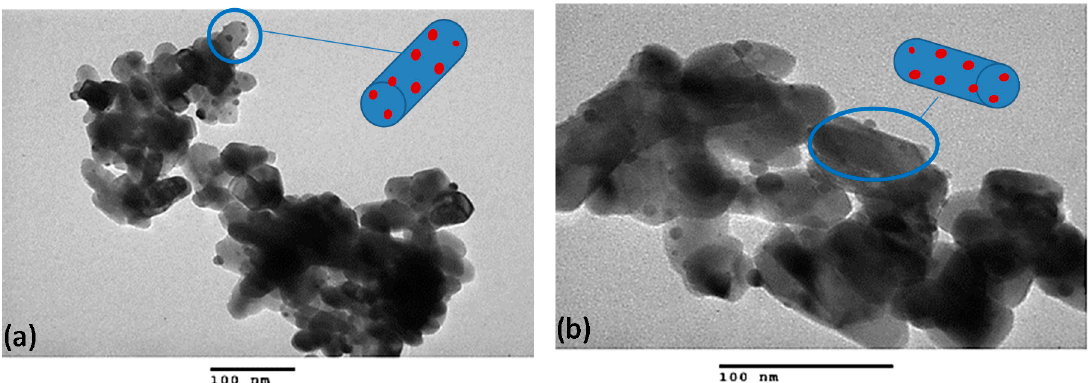
Figure 1. TEM images of Ag-loaded TiO 2 nanoparticles at different magnifications